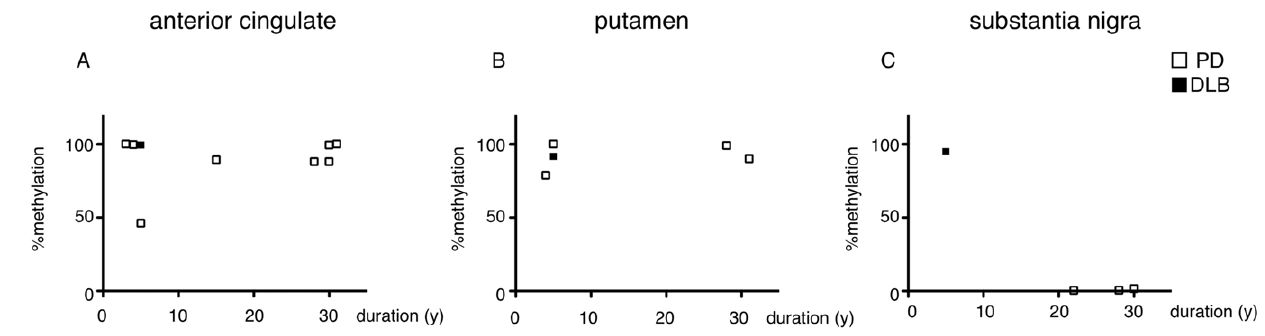
Figure 5. Specific CpG-2 demethylation in substantia nigra of Parkinson’s disease patients. CpG-2 methylation in the anterior cingulate cortex (A), putamen (B), and substantia nigra (C) of PD (open boxes) and DLB (closed boxes) are plotted against disease